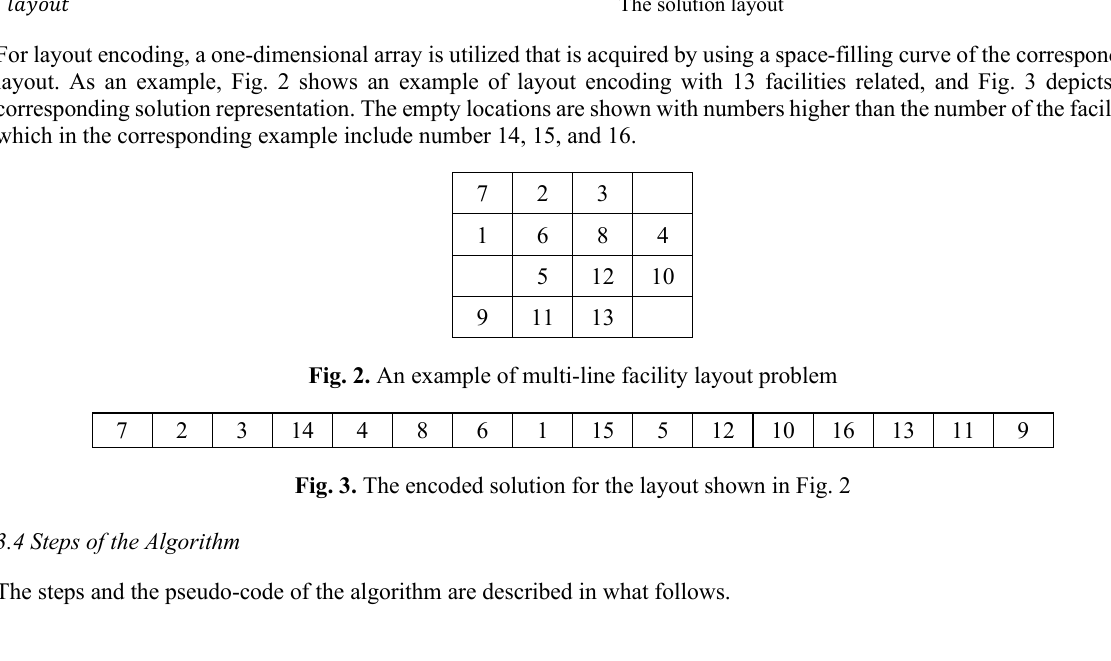
The total material handling cost related to solution layout The temperature where the solution was acquired The best-known local solution The solution layout